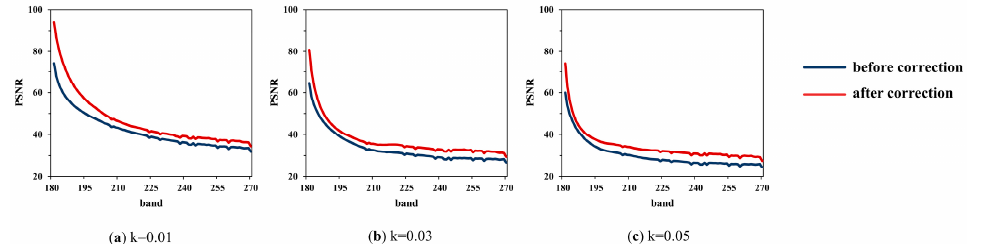
Figure 10. PSNR of each band between original image and images with k of ( a ) 0.01; ( b ) 0.03; and ( c ) 0.05.